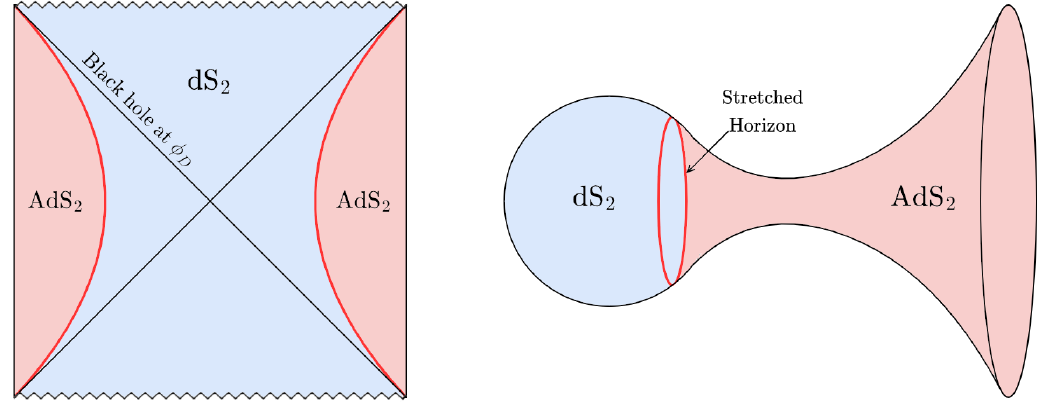
Figure 4 . Left: The Penrose diagram of the interpolating geometry that contains the black hole in a de Sitter static patch in the deep interior and interpolates to an AdS 2 boundary. Right: The same geometry in Euclidean signature, where the Euclidean black hole horizon now caps off at the pole of the